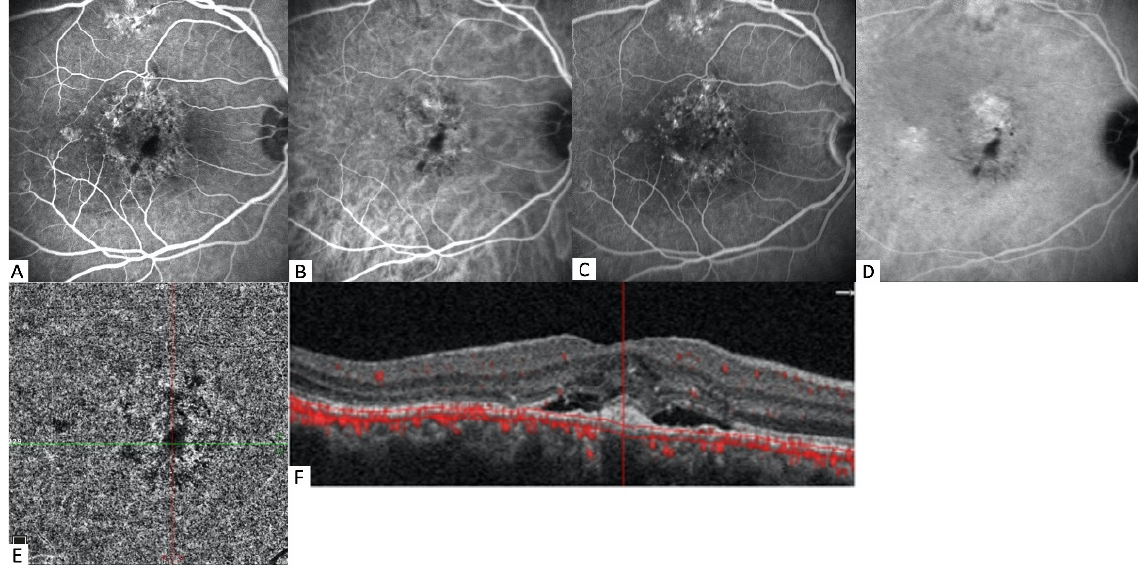
Figure 3. Multimodal images of a 51-year-old male patient. ( A ) The early phase of FA shows ill-defined areas of irregular staining/leaking RPE with “stipples” of hyperfluorescence. ( B ) The early phase of ICGA detects vascular networks of MNV. ( C ) The late frame of FA with a remaining stippled appearance. ( D ) In the late phase of ICGA, a neovascular network has not been shown. ( E ) In the choriocapillaris slab of OCTA frames, there is no sign of any structure of neo-vessels. ( F ) The corresponding B-scan with flow overlay reveals subretinal fluid with subfoveal debris centered in the shallow and irregular PED, and dilated Haller vessels with overlying choriocapillaris thinning, likely due to the subfoveal mass blockage; flow signal was not detected.